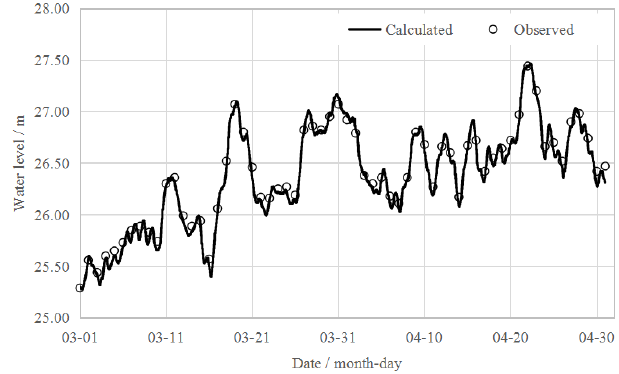
Figure 5. Water level process of forecasting and observed at up- stream transverse cofferdam in March and April 2018.